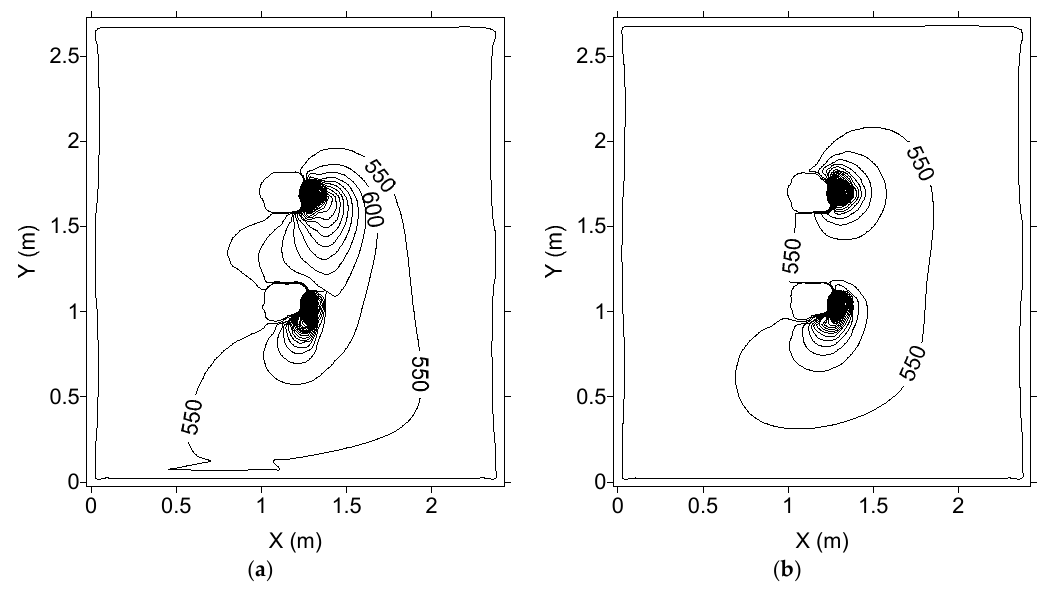
Figure 11. CO 2 concentration field for the plan XY, Z23, numerically calculated. ( a ) Associated with the k ‐ epsilon turbulence model and ( b ) associated with the RNG turbulence model. Table 6. CO 2 concentration, in the breathing area, numerically calculated.